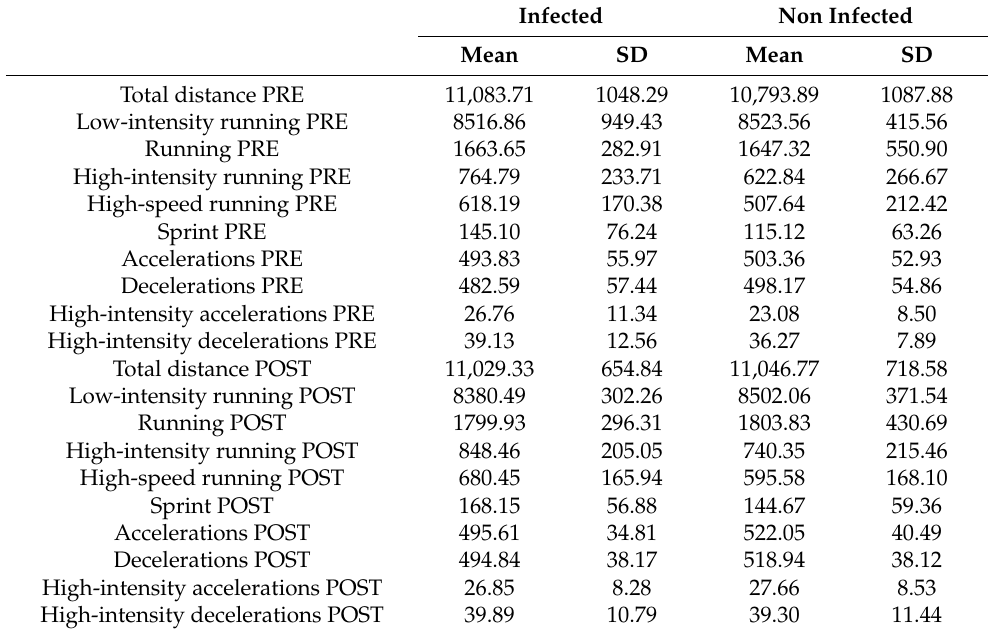
Table 3. Descriptive statistics for running parameters.